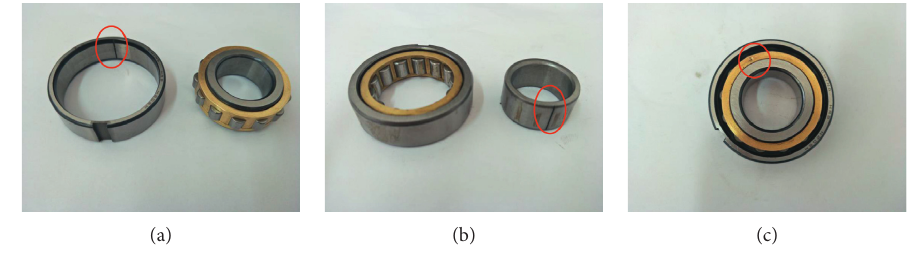
Figure 5: The types of bearing fault: (a) outer ring fault, (b) inner ring fault, and (c) rolling body fault.